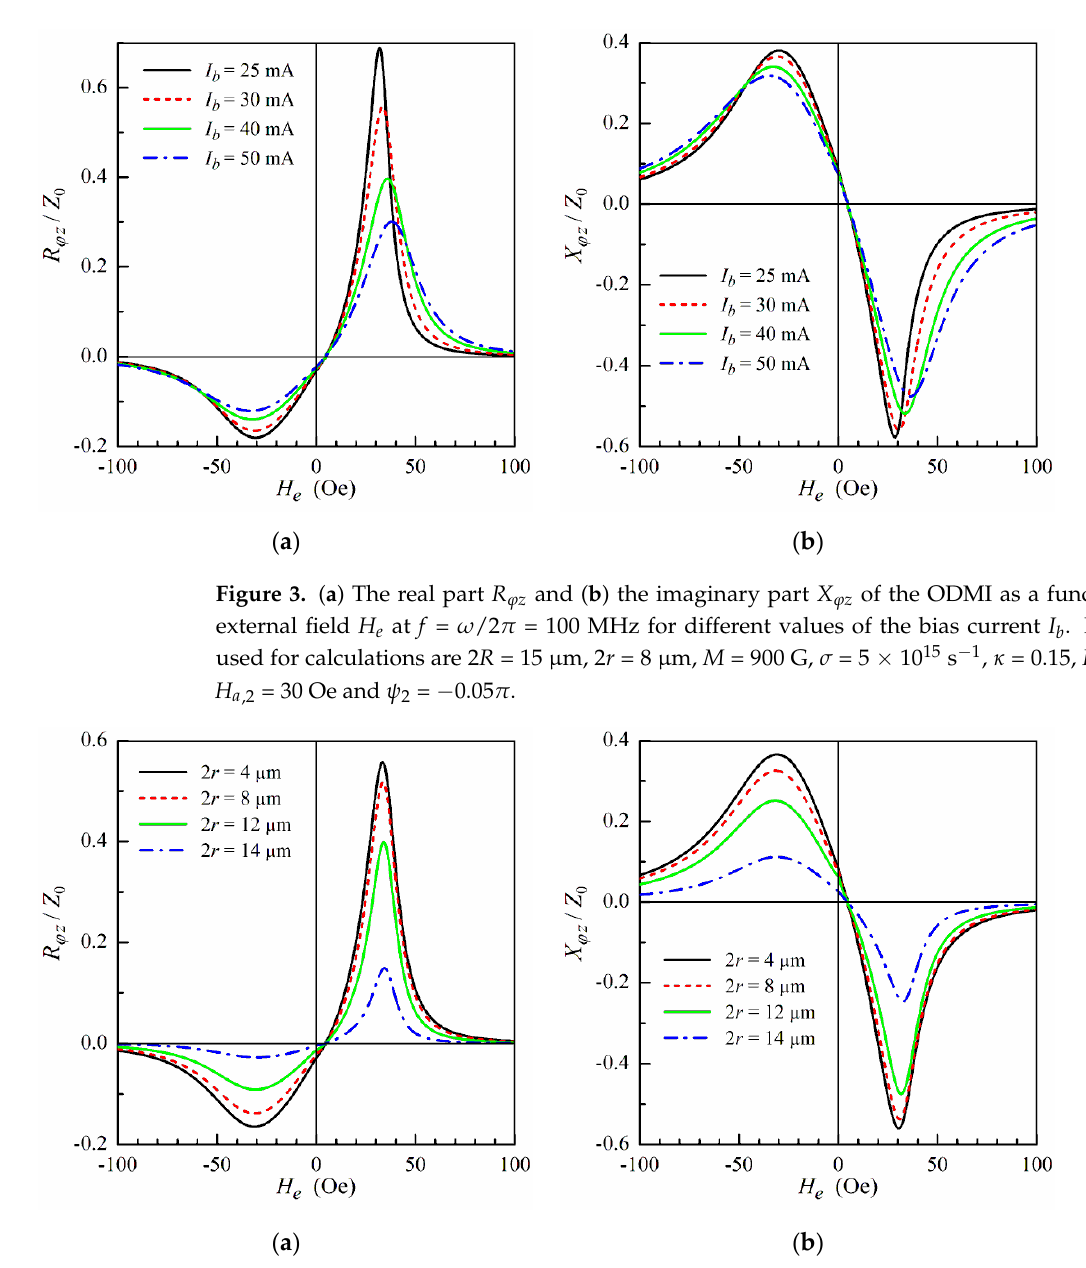
Figure 4. ( a ) The real part R ϕ z and ( b ) the imaginary part X ϕ z of the ODMI as a function of the external field H e at f = 100 MHz and I b = 30 mA for different values of the core region diameter 2 r . Other parameters used for calculations are the same as in Figure 3.